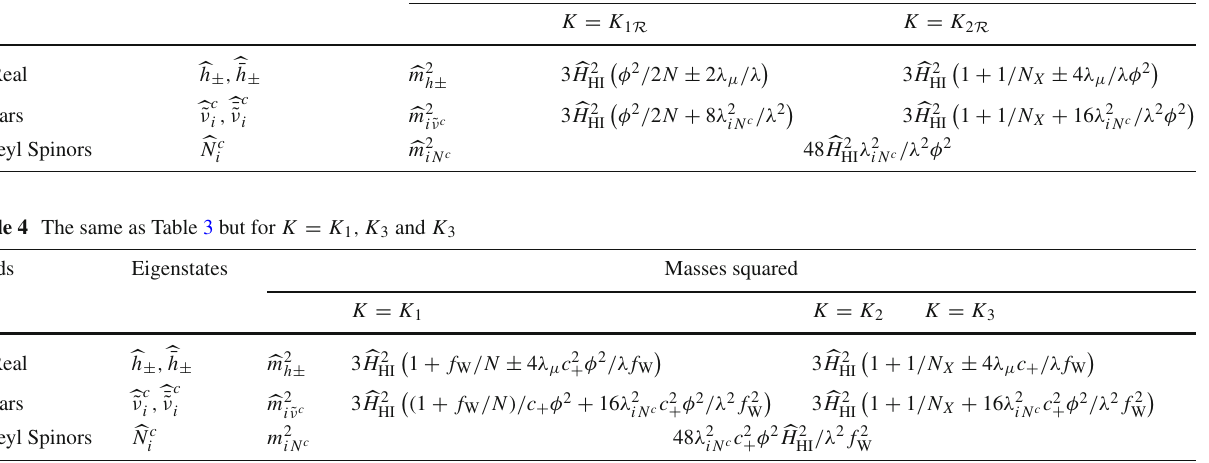
Table 3 Mass-squared spectrum of the non-inflaton sector for K = K 1 R and K 2 R along the path in Eqs. (22) and (68) Fields